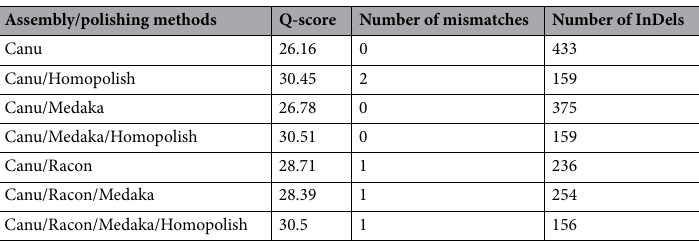
Assembly/polishing